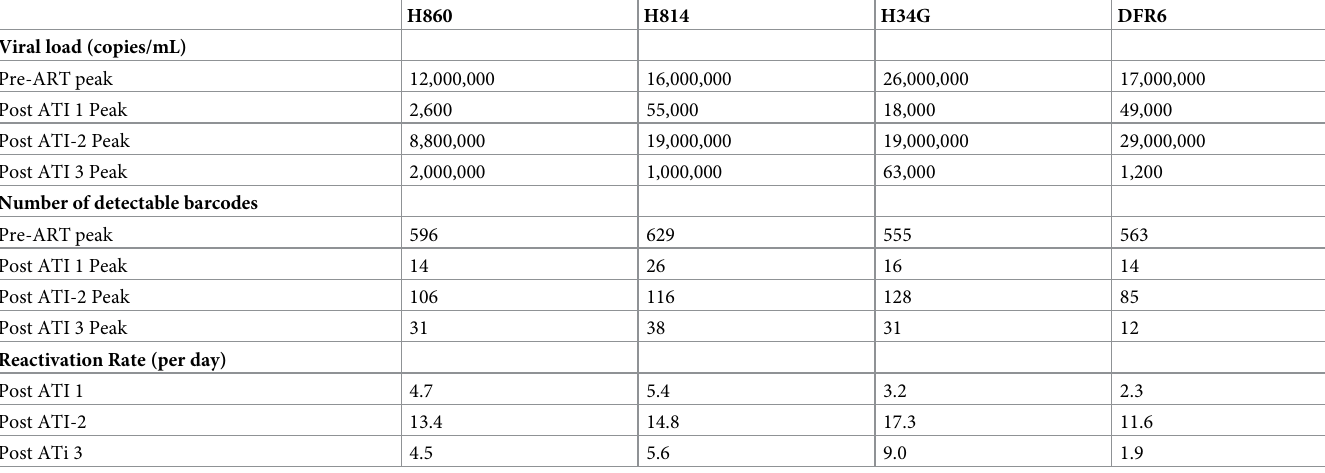
Table 1. Summary of viral replication and reactivation